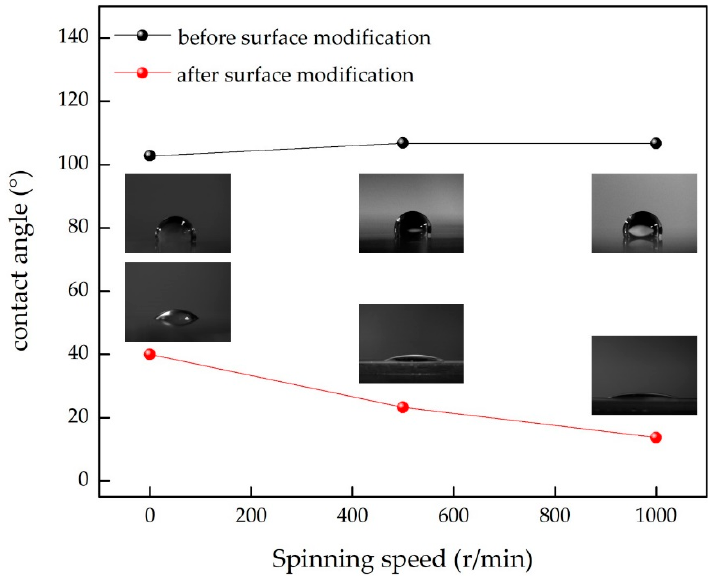
Figure 4. The surface contact angle of PDMS films at the three studied rotation speeds.